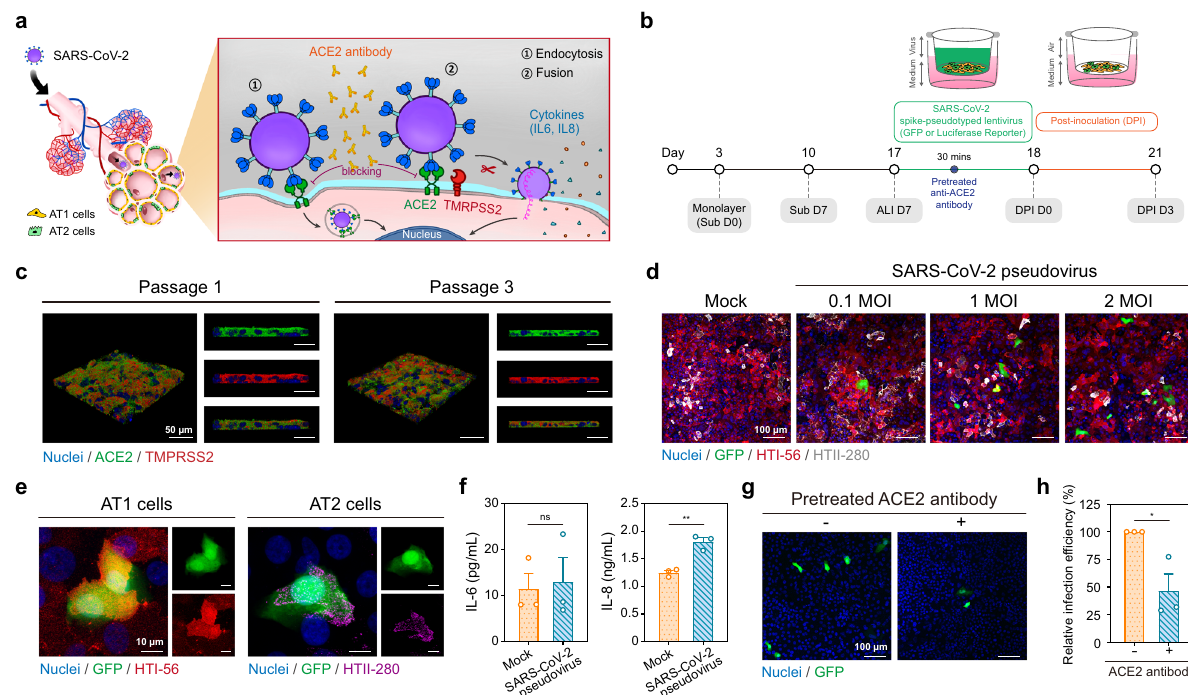
Fig. 4 SARS-CoV-2 infection in human alveolar model. a Schematic of experiment in which HPAEpiCs were infected with SARS-CoV-2 pseudovirus. Experiments were devised to determine whether the AT1 and AT2 cells in our model could be infected by the virus, whether the model could serve as a preclinical testing platform for drug strategy development. b Timeline fl owchart showing HPAEpiC culture steps during SARS-CoV-2 pseudovirus infection process. For virus infection, the human alveolar model was established under Sub-culturing for 7 days and ALI culturing for 7 days. c After the human alveolar model was established, the HPAEpiCs were stained with ACE2 (green) and TMPRSS2 (red) antibodies, both of which are key proteins for SARS- CoV-2 to enter target cells. d , e After 3 days of SARS-CoV-2 pseudovirus infection (GFP reporter, MOI = 0.1, 1, and 2), HPAEpiCs were stained with HTI-56 (red) and HTII-280 (purple) antibodies, and the GFP fl uorescence signal was observed ( d ). High-magni fi cation images showing AT1 and AT2 cells express GFP fl uorescence, which indicate that both cell types were infected with SARS-CoV-2 pseudovirus ( e ). f After 3 days of SARS-CoV-2 pseudovirus infection (MOI = 2), proin fl ammatory cytokine IL-6 and IL-8 concentrations produced by the HPAEpiCs were con fi rmed. IL-8 was released at a signi fi cant level when the HPAEpiCs were infected with the SARS-CoV-2 pseudovirus. g , h Before virus infection, the HPAEpiCs were incubated with anti-ACE2 antibody for 30 min to block ACE2 receptors. After 3 days of SARS-CoV-2 pseudovirus infection (GFP reporter, MOI = 2) of the ACE2-blocked alveolar model, the GFP fl uorescence signal was observed ( g ) and the infection ef fi ciency was quanti fi ed ( h ). The anti-ACE2 antibody-pretreated model reduced the infection ef fi ciency by half. Data and error bars represent mean ± SEM from three separate experiments. Student ’ s t test ( f , h ). * p < 0.05; ** p < 0.01; ns non- signi fi